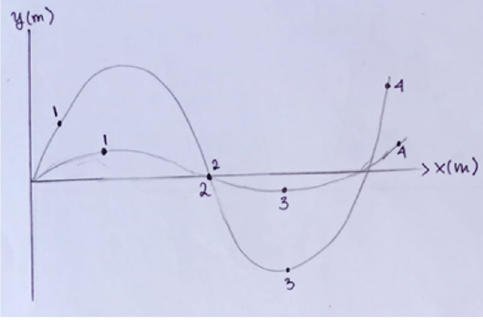
FIG. 5. Student ’ s drawing with the next profile become